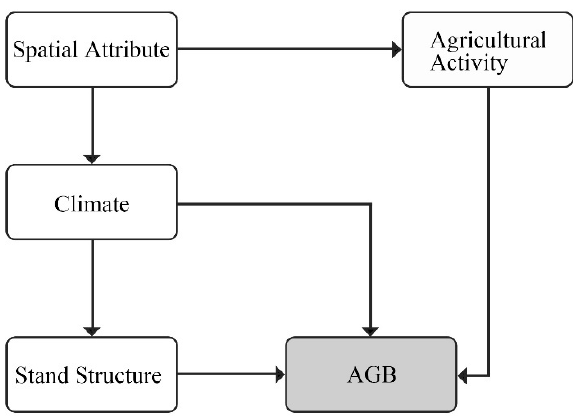
Figure 2. Conceptual model of SEM.